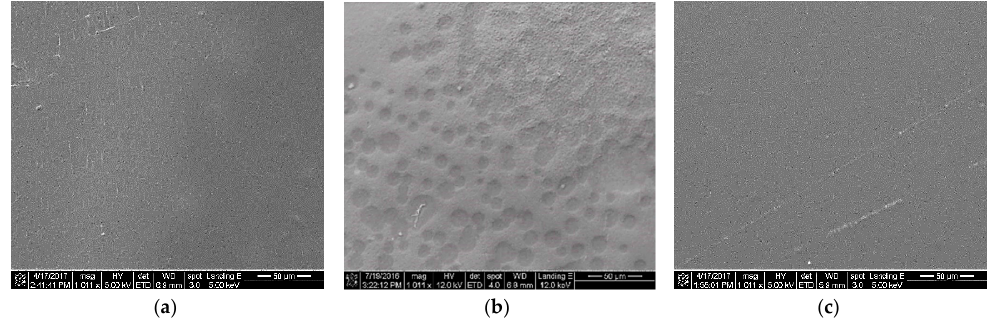
Figure 4. Morphologies of the membrane surfaces in contact with the liquid in the strip cell ( a ) before the permeation experiment; ( b ) conventional PIM scheme with 5 M HCl as the strip solution, after 20 h of permeation experiment; ( c ) PIMSD scheme with 5 M HCl as the strip solution, after 20 h of permeation experiment.